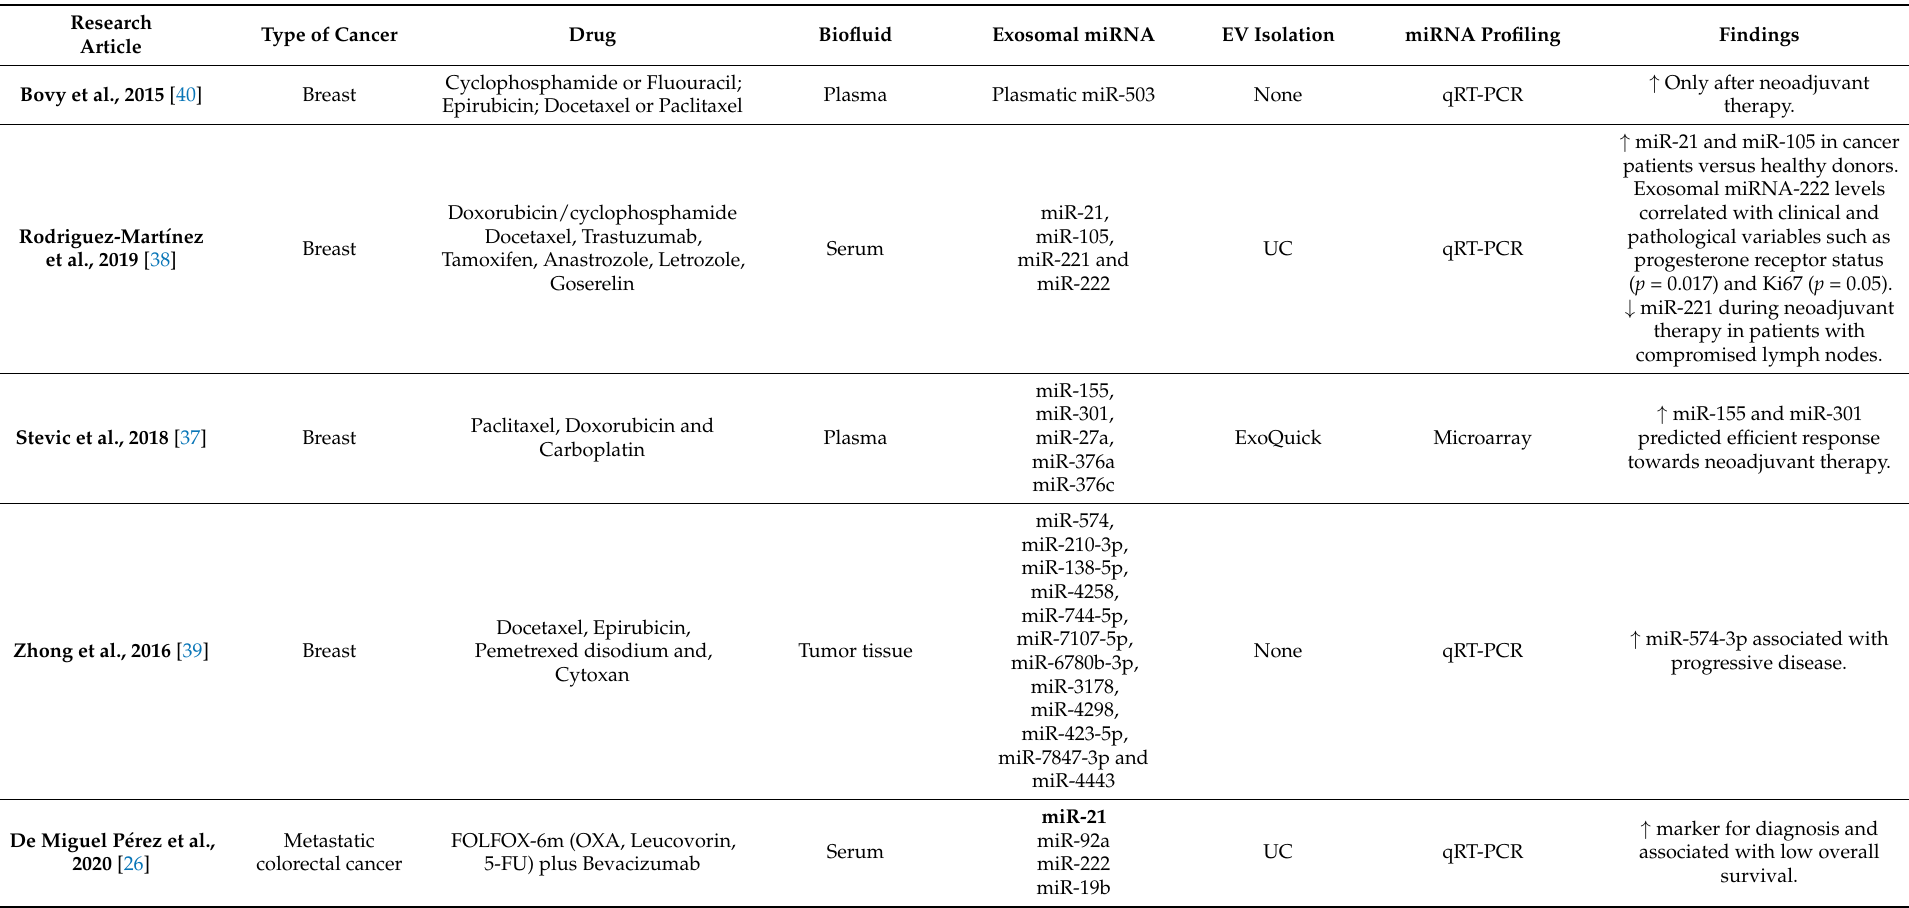
Table 2. List of miRNAs involved in chemoresistance or chemosensitivity that were found amongst the set of research articles included in this review. miRNAs that were found in multiple studies of the same type of cancer have been bolded. Abbreviations: UC , Ultracentrifugation; FU or 5-FU , 5-Fluorouracil; DLBCL , Diffuse large B-cell lymphoma; HCC , Hepatocellular carcinoma; OXA , Oxaliplatin; GEM , Gemcitabine; TCGA , The Cancer Genome Atlas; NSCLC :, Non-small cell lung cancer; GEO , Gene Expression Omnibus; CMM , Cutaneous Malignant Melanoma; MAPKis , Mitogen activated-protein kinase pathway inhibitors; GBM , Glioblastoma multiforme; TMZ , Temozolomide; CSF , cerebrospinal fluid; BZ ,